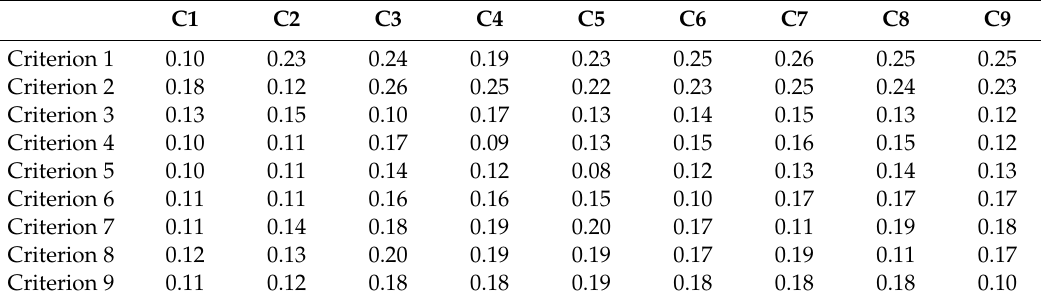
Table 4. Total relation matrix for the